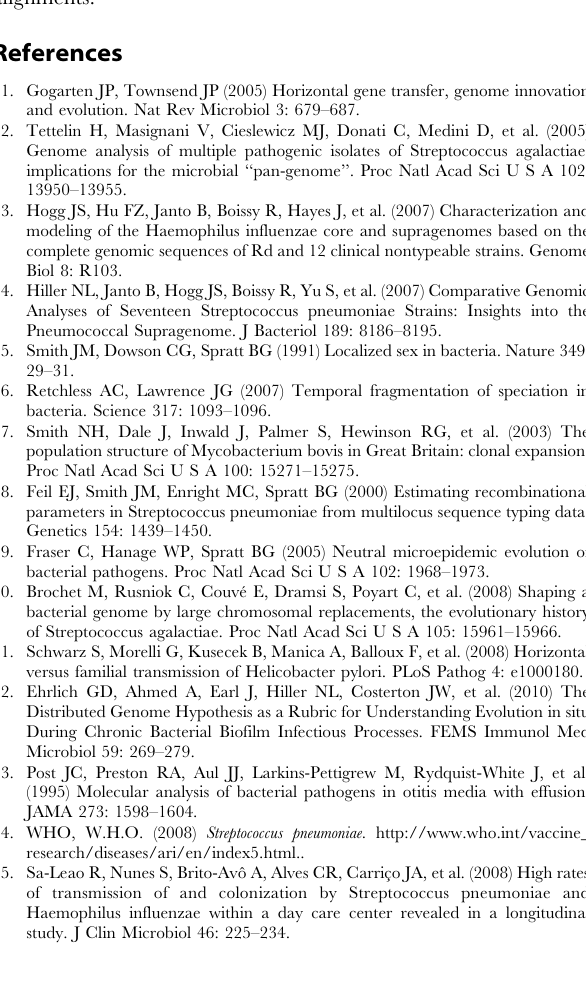
each other on the chromosome. (B) Alignment of 4 genes, two from strain ST13v1 (prefix:CGSSp14BS292) and two from ST13v12 (prefix: CGSSpBS293). Yellow, blue, red, pink, and gray highlight identical regions. Comparison between both strains suggests that sequence differences were created by site-specific DNA inversion systems, where DNA inversions occurred within the coding regions of restriction endonuclease subunits resulting in genetic polymorphism, as previously observed in S. pneumoniae [35]. Table S1 List of SNPs that differentiate strains isolated from patient 19. The first 3306 rows are loci that contain at least one SNP among theST13 strains; the remaining rows are loci that are identical among the ST13 strains, but are variable relative to ST2011v4. QS = sequencing quality score. Table S2 List and annotation of 173 distributed clusters that differentiate the strains isolated from patient 19. 47 of these vary among the ST13 strains (purple, pink, blue and yellow). Table S3 List of the coding sequences within the NGs (W) as well as those in the surrounding regions (S) that contain allelic differences among ST13 strains. c =complement. Table S4 Map of the contigs from ST13v1, ST13v6, ST13v12, and ST2011v4 onto the assembly used for whole genome